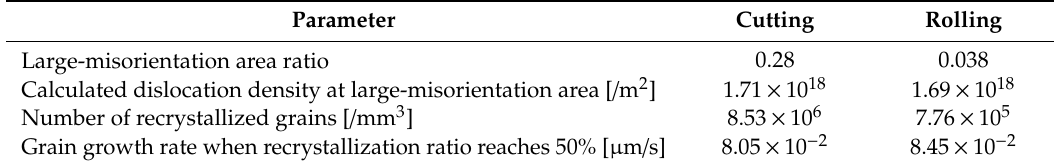
Figure 15. Time variation of recrystallization ratio during heat treatment at 600 °C, as calculated using the model. Table 5. Recrystallization process properties of the chip and rolled specimens at 600 °C.